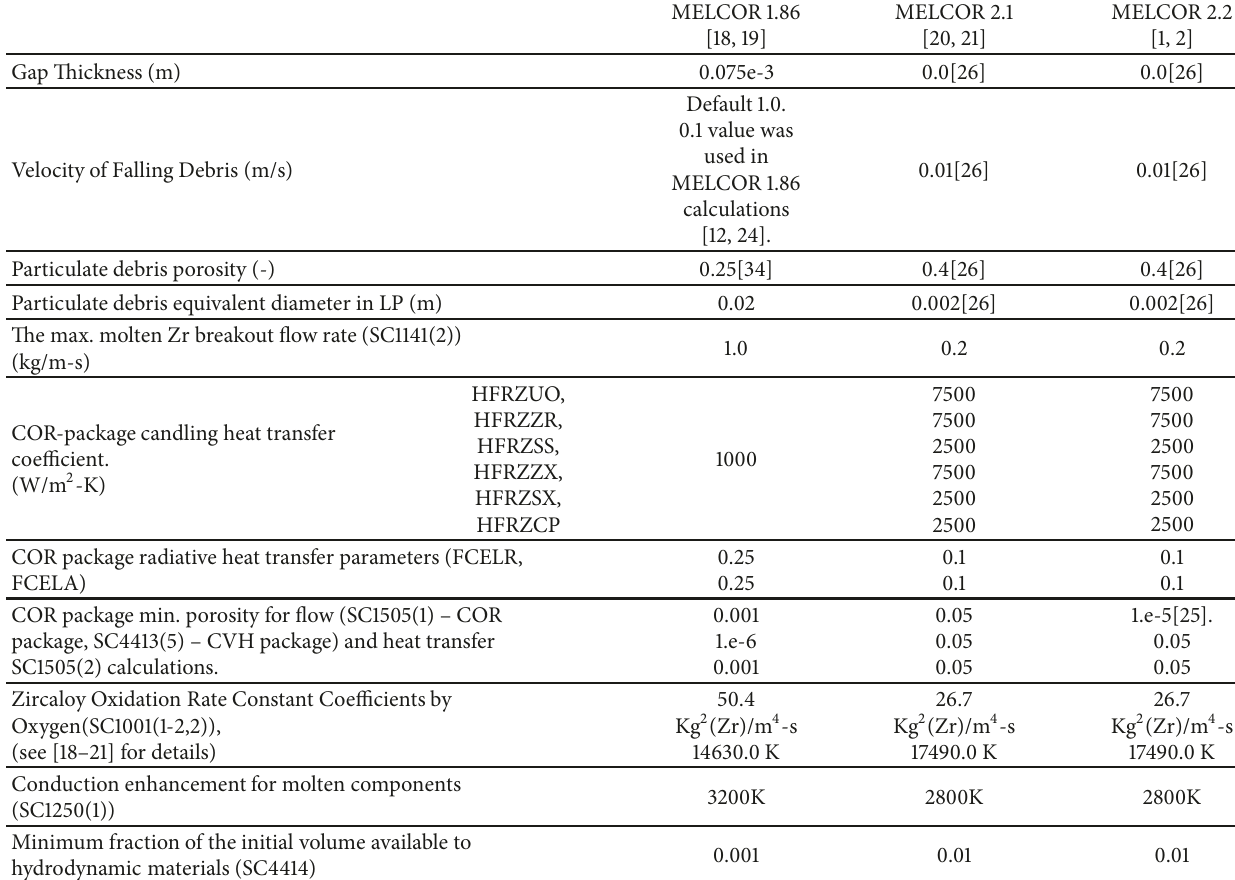
Table 1: MELCOR modeling